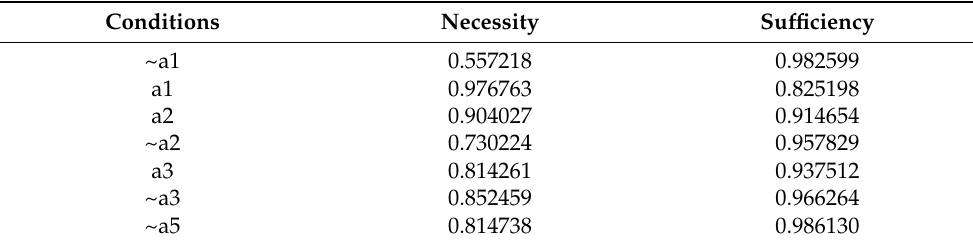
Table A9. Necessity and sufficiency analysis of conditions (outcome ~A2).